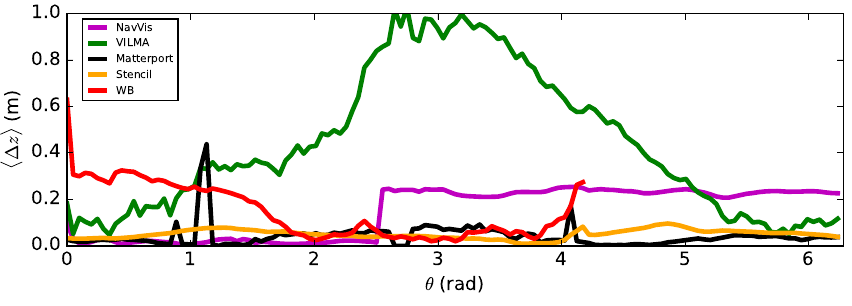
Figure 23. Average height difference ∆ z as a function of the location on the ramp θ . (cid:104) ∆ z (cid:105) is the local average of measured point-to-point distances between a method and the reference point cloud. See the text for